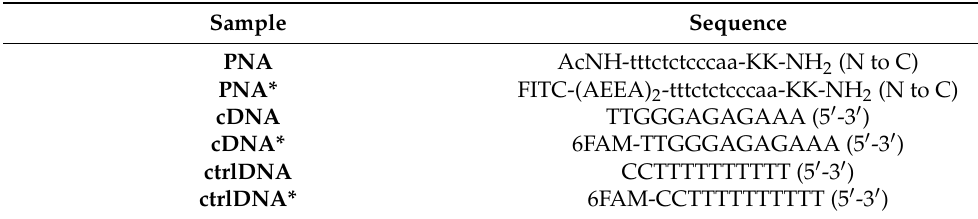
Table 1. DNA and PNA sequences used in this study.